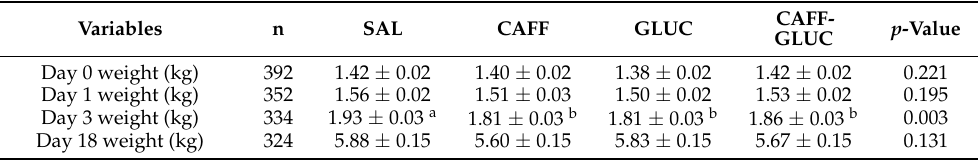
Table 2. Body weights (kg) at birth, 1, 3 and 18 days of age, for piglets allocated to oral treatments at birth groups; saline (SAL), caffeine (CAFF), glucose (GLUC) and caffeine plus glucose (CAFF-GLUC). Variables n SAL CAFF GLUC CAFF- GLUC p -Value